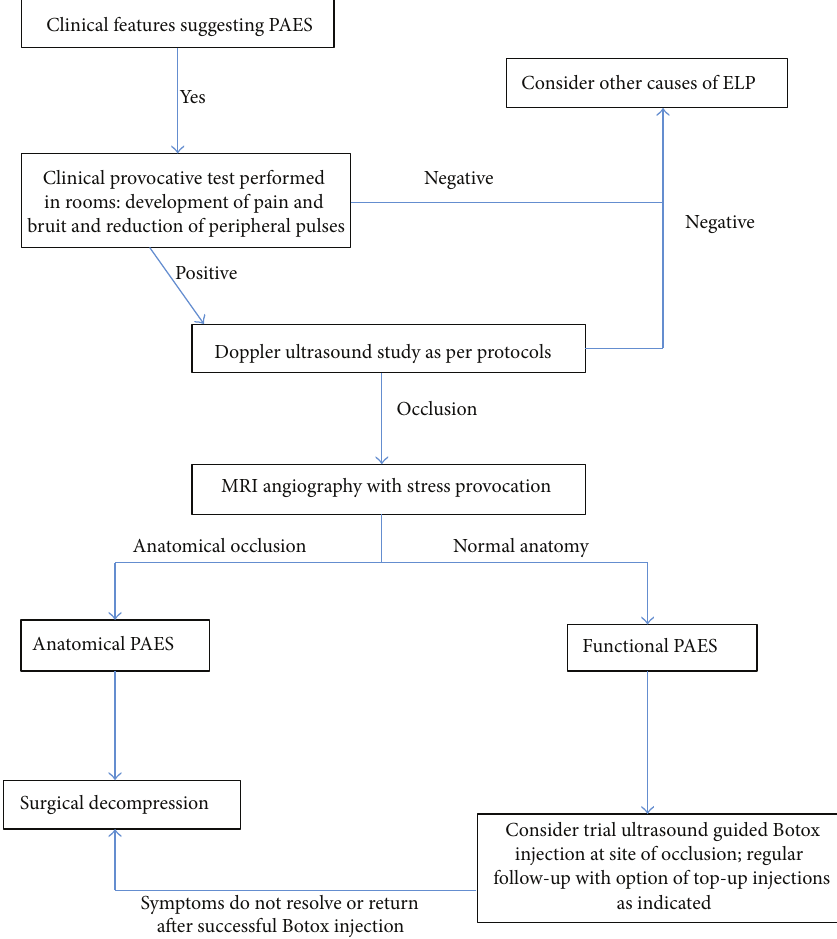
Figure 3: Assessment and treatment protocols for suspected